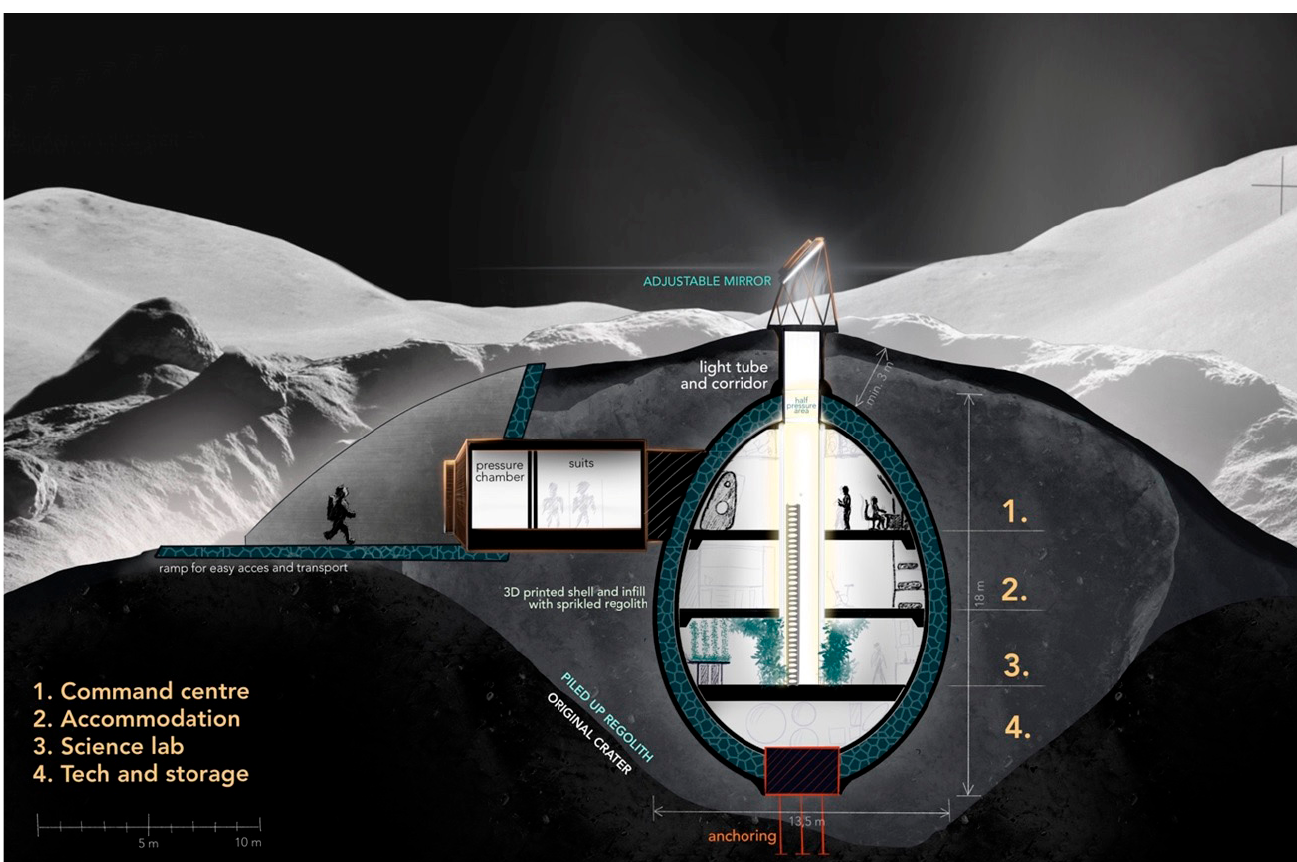
Figure 8. Cross-sectional view of the final variant of one egg-shaped habitat, semi-submerged to an existing crater with a piled-up regolith.